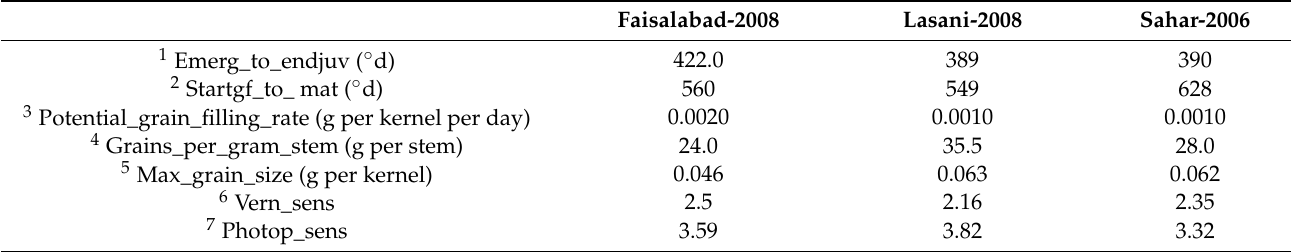
Table 2. Genetic Coefficients for APSIM Wheat